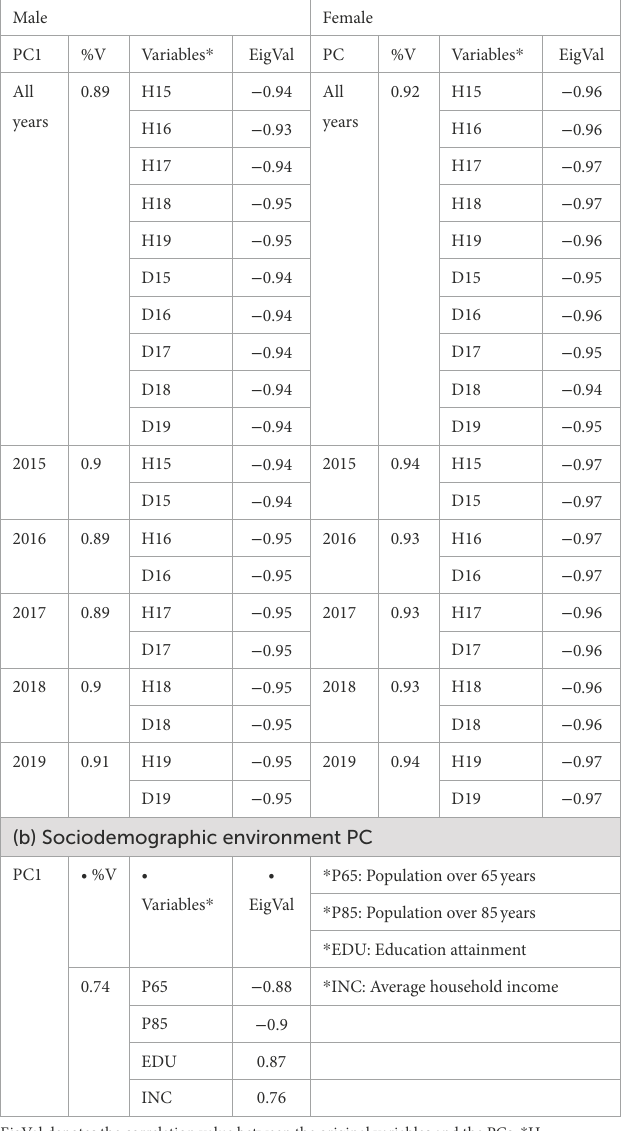
TABLE 1 Description of the selected PCs.